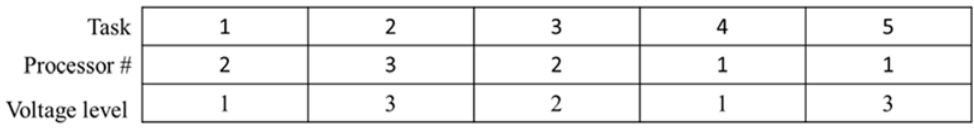
Figure 4. Solution encoding.